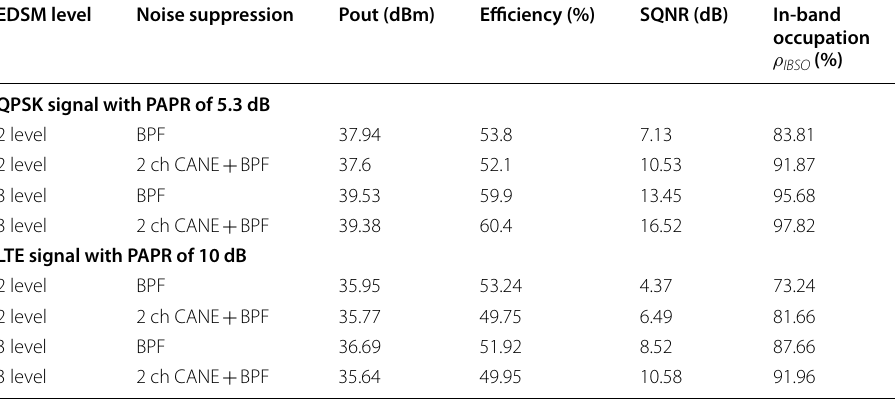
Table 3 Output Power and Drain Efficiency (DE) of Two PAs Combining module EDSM level Noise suppression Pout (dBm) SQNR (dB)